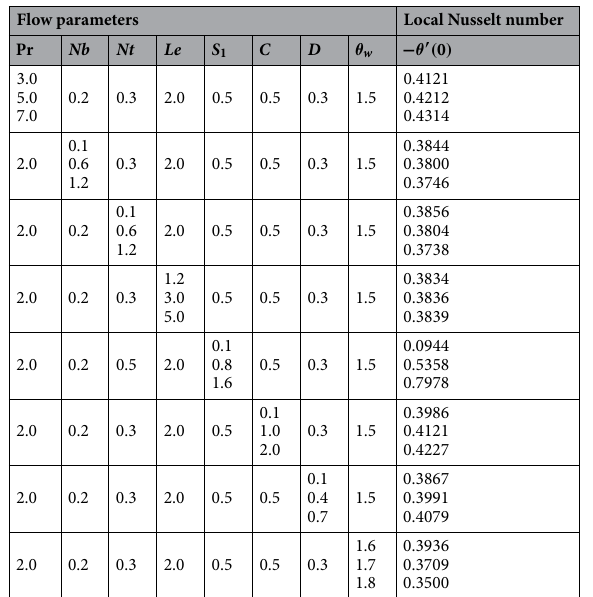
Table 2. Outcomes of